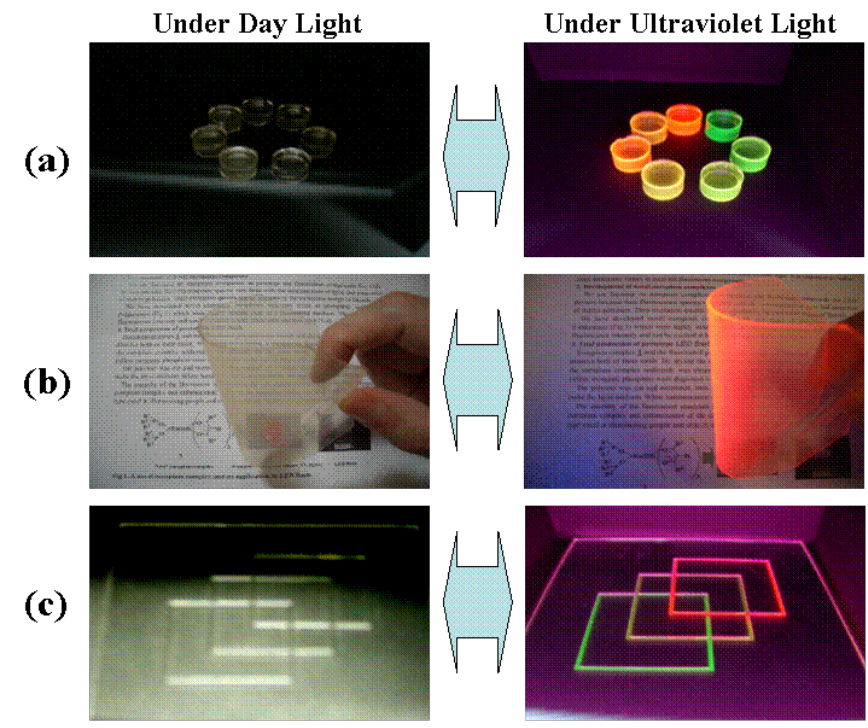
Figure 19. Colorless and transparent emission materials produced by dissolving Eu(III) complexes and/or Tb(III) complexes in a polymer. (a) block, (b) flexible sheet, (c) print on